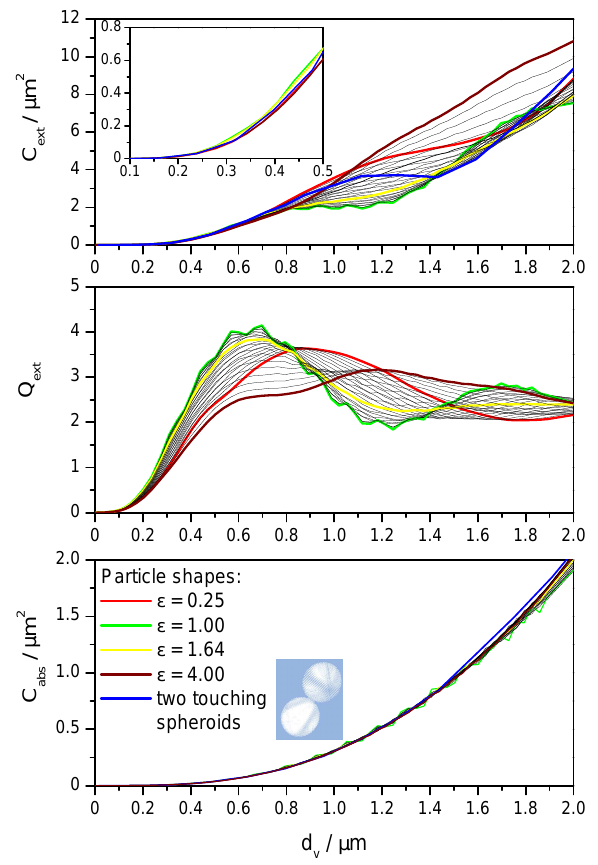
Fig. A2. Shape dependency of the optical cross sections and ef- ficiencies of randomly oriented spheroidal particles. All results hold for a wavelength of 500nm and a complex refractive index of 1.5+0.014i. Top panel: extinction cross sections for all 29 con- sidered particle shapes between ε = 0 . 25 and ε = 4 . 0. Results of selected shapes are highlighted by coloured curves, as denoted in the legend of the bottom panel. The blue trace shows the addi- tional result for an aggregate particle composed of two touching spheroids. The insert shows the results for the coloured curves in an expanded view for d v from 0.1 to 0.5µm. Middle panel: same set of calculations as in the top panel, now expressed as extinction efficiency. Bottom panel: absorption cross sections for all 29 con- sidered spheroidal particle as well as the aggregate